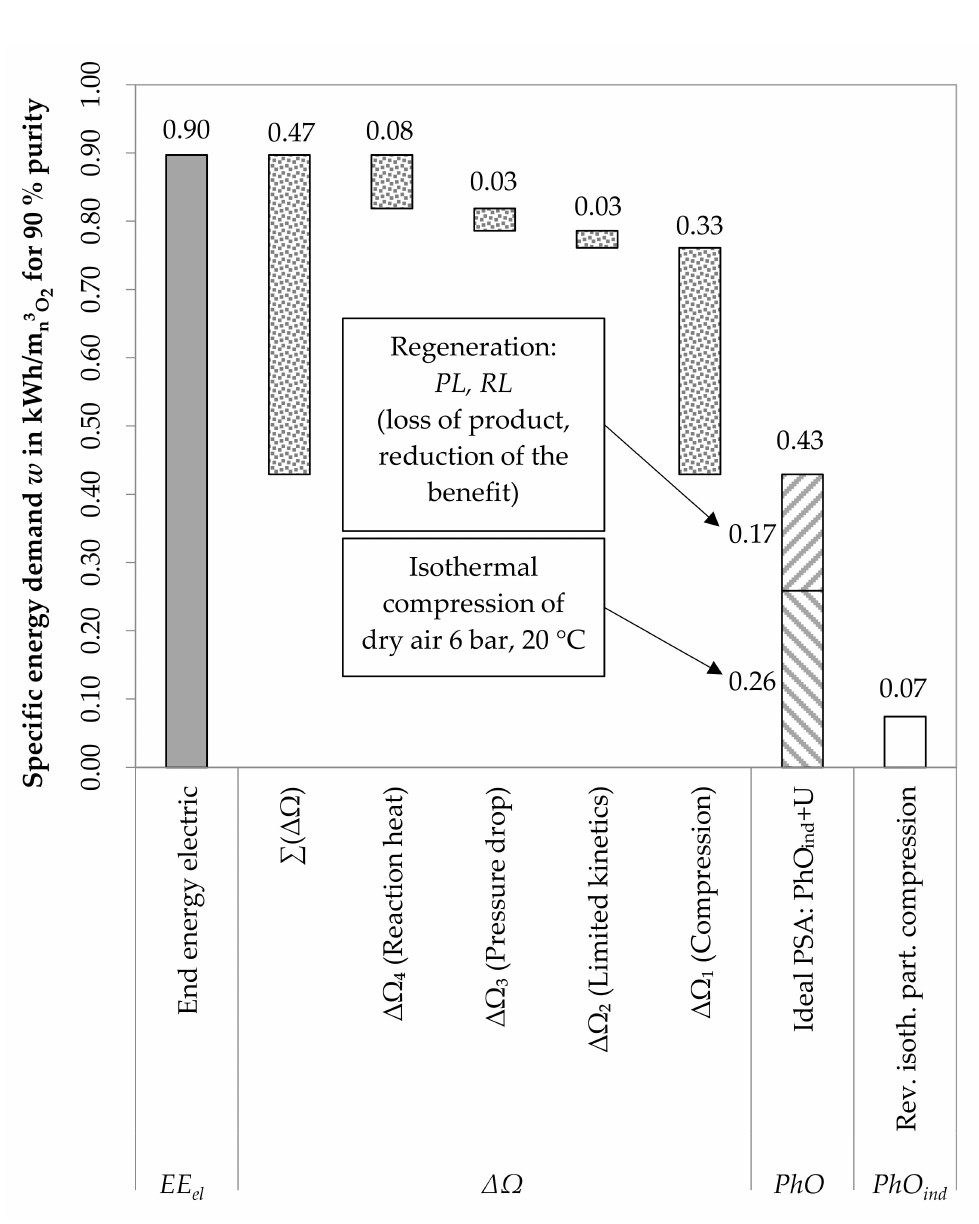
Figure 9. Evaluation of the oxygen purification using PSA with the PhO